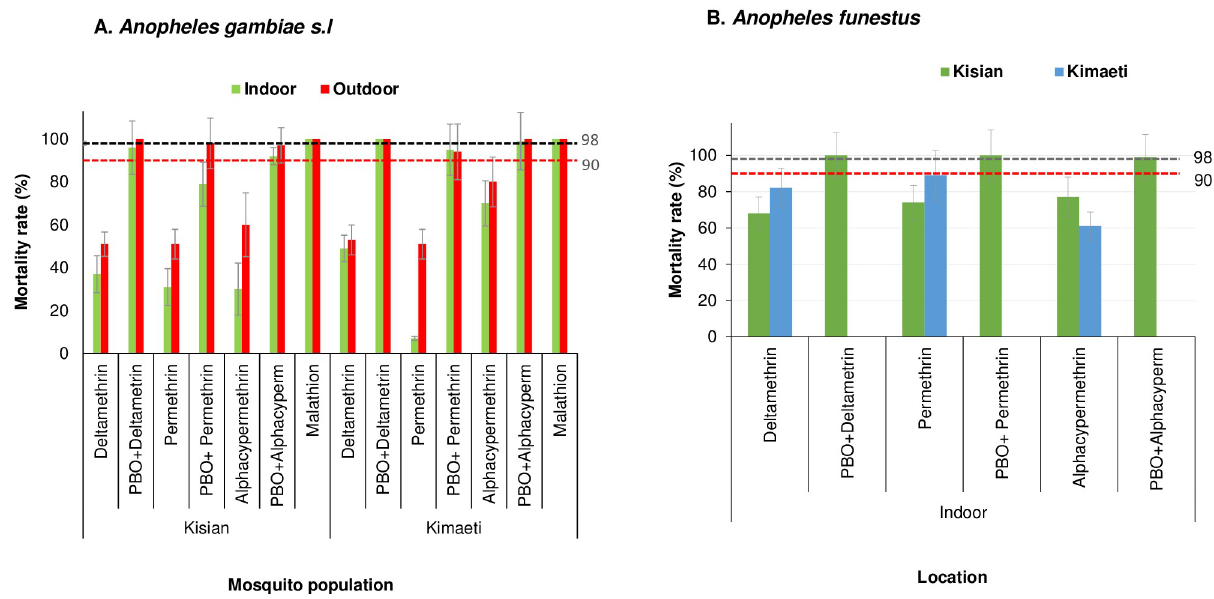
Fig 1. Percentage mortality rates for indoor and outdoor resting A.) An gambiae s . l B.) An funestus F1 progeny from Kisian (lowland) and Kimaeti (Highland) using WHO tube bioassays. Error bars indicate 95% confidence intervals. The 90% mortality threshold for declaring suspected resistance and 98% mortality threshold for calling full susceptibility based on the WHO criteria are